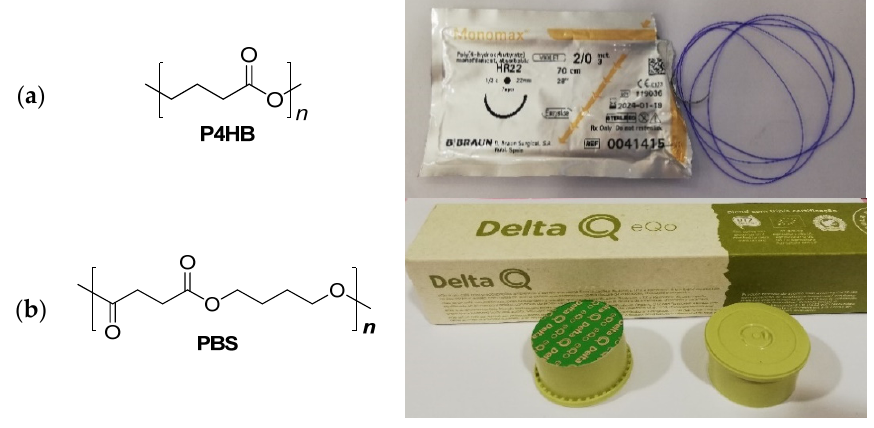
Figure 2. ( a ) Non-infected commercial surgical suture; ( b ) Delta Q eQo coffee capsules.